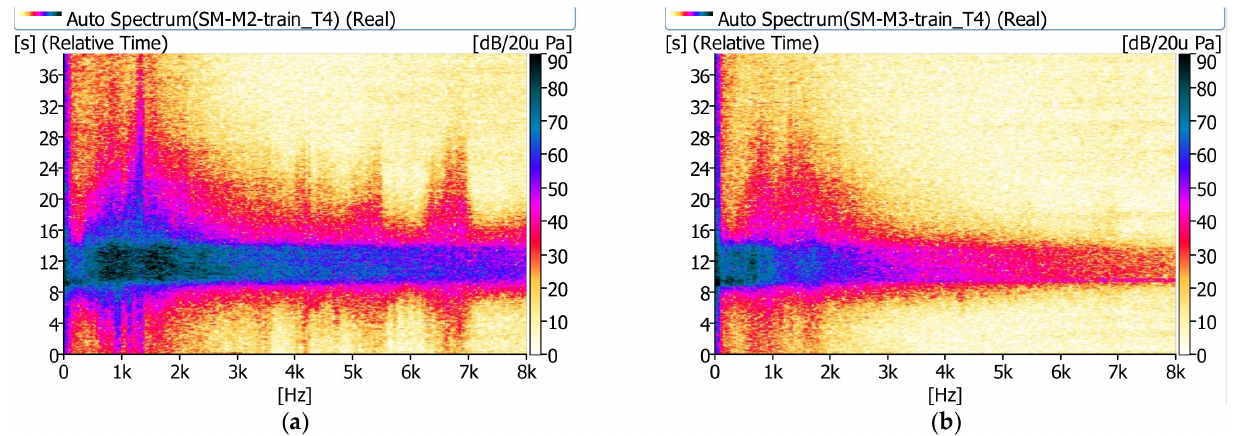
Figure 9. Spectrograms recorded during the passage of a passenger train (T4): ( a ) next to the bridge (m.p. M2), ( b ) under the bridge (m.p. M3).